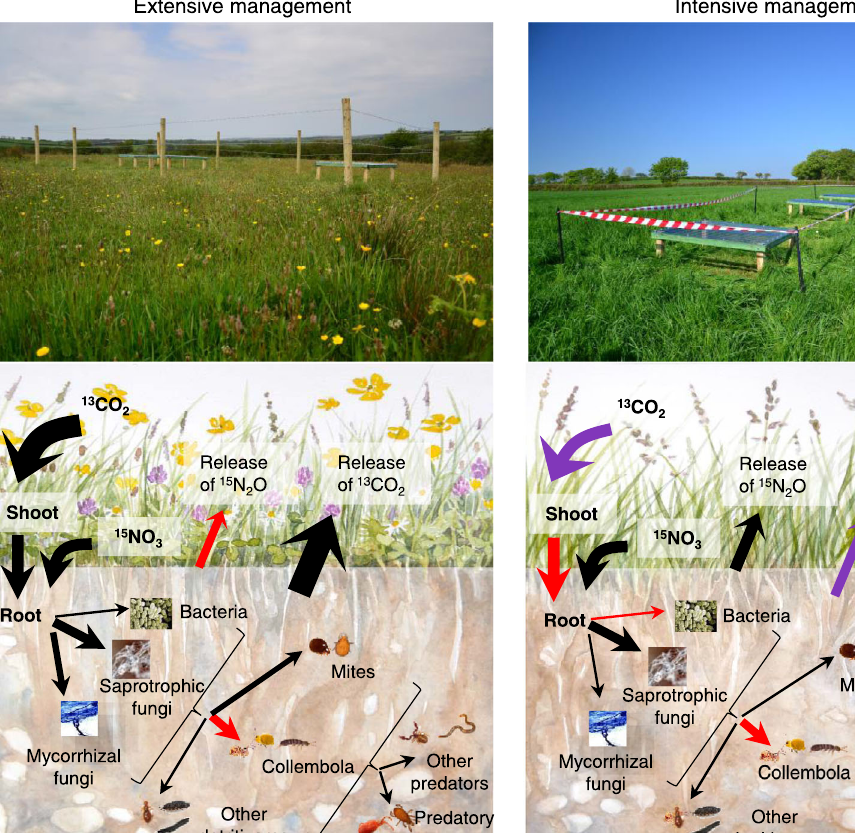
Fig. 6 | Summary schematic on management and drought impacts on tracers transfer in the plant-soil system. Schematic of the in fl uence of grassland man- agement (leftpanel extensive, right panelintensive) and drought (negative impact inred,positiveimpactinviolet,andnosigni fi cantimpactinblack)on 13 Cuptakeby plant shoot and transfer to roots, soilorganisms and CO 2 ef fl ux, and 15 N transferto